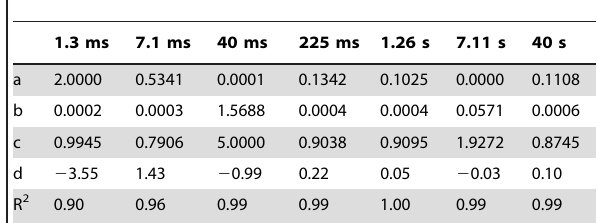
Table 3. Parameters for the k i (L) functions in m2SR. Table 4. Parameters for the k i (L) functions in